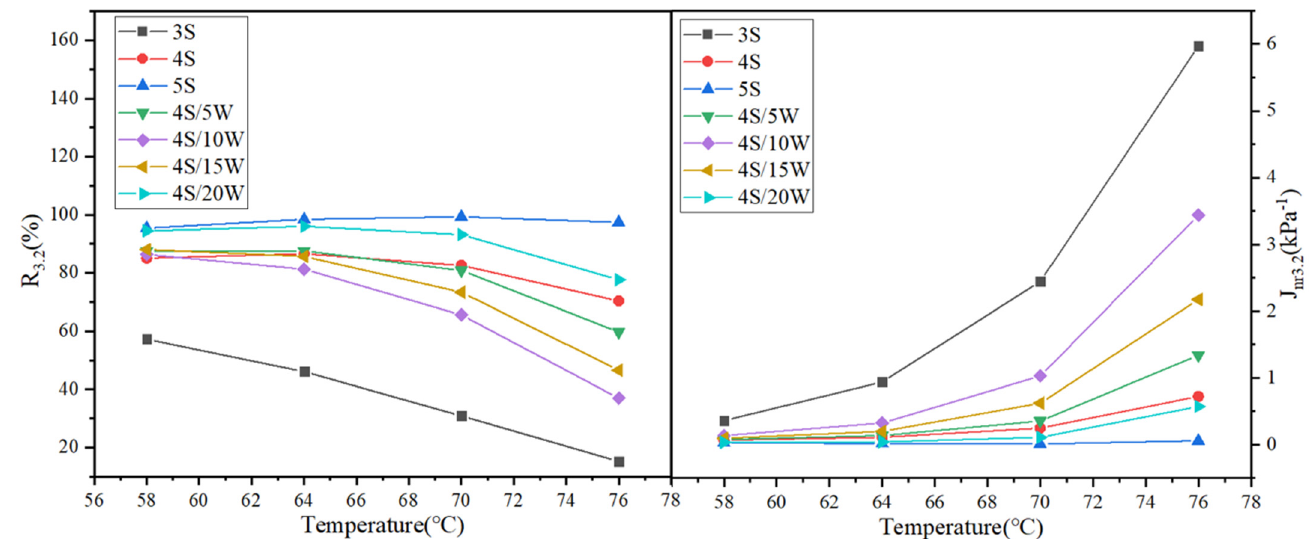
Figure 8. R 3.2 and J nr3.2 of WPU/SBS composite modified asphalt.